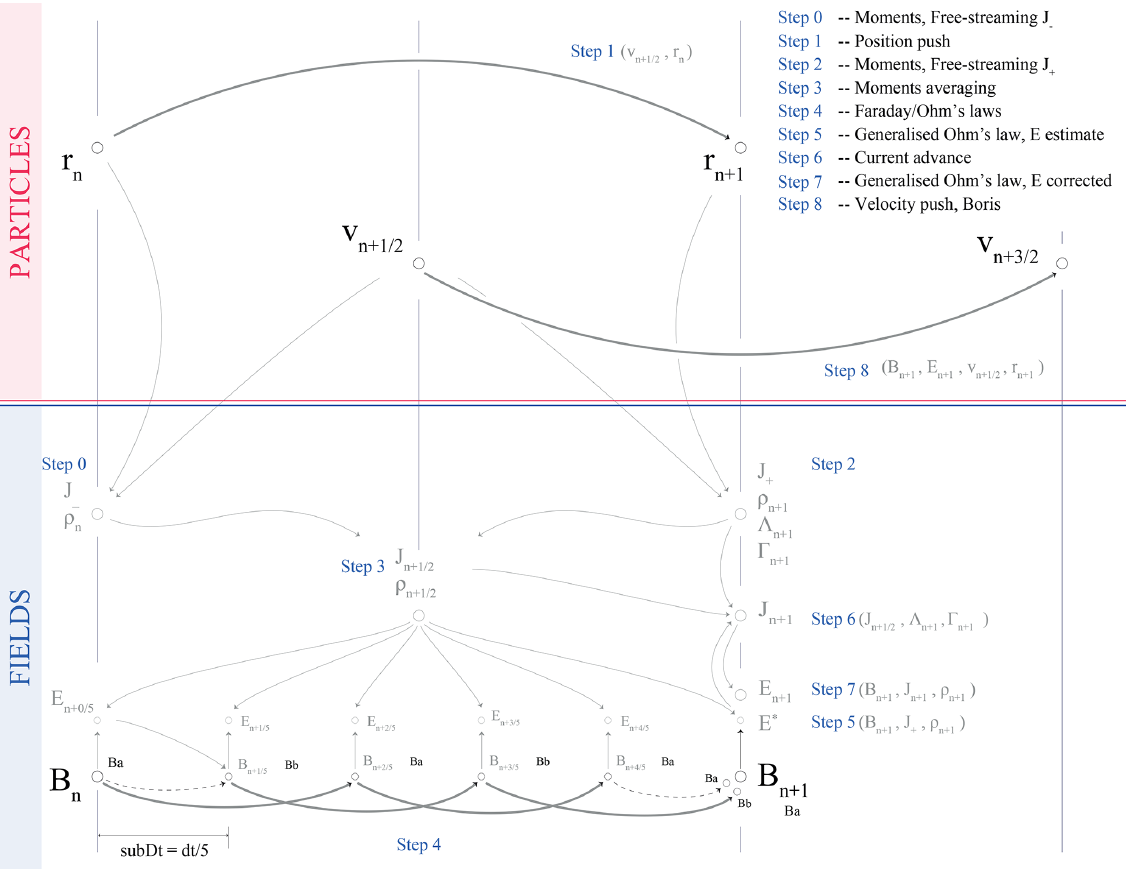
Figure 1. Algorithm of Menura ’s solver, with its main operations numbered from 0 to 8, as organised in the main file of the code. r and v are the position and velocity vectors of the macroparticles. Together with the magnetic field B , they are the only variables necessary for the time advancement. The electric field E , the current J , and the charge density ρ , as well as the CAM pseudo-moments (cid:51) and (cid:48) , are obtained from r , v and B .